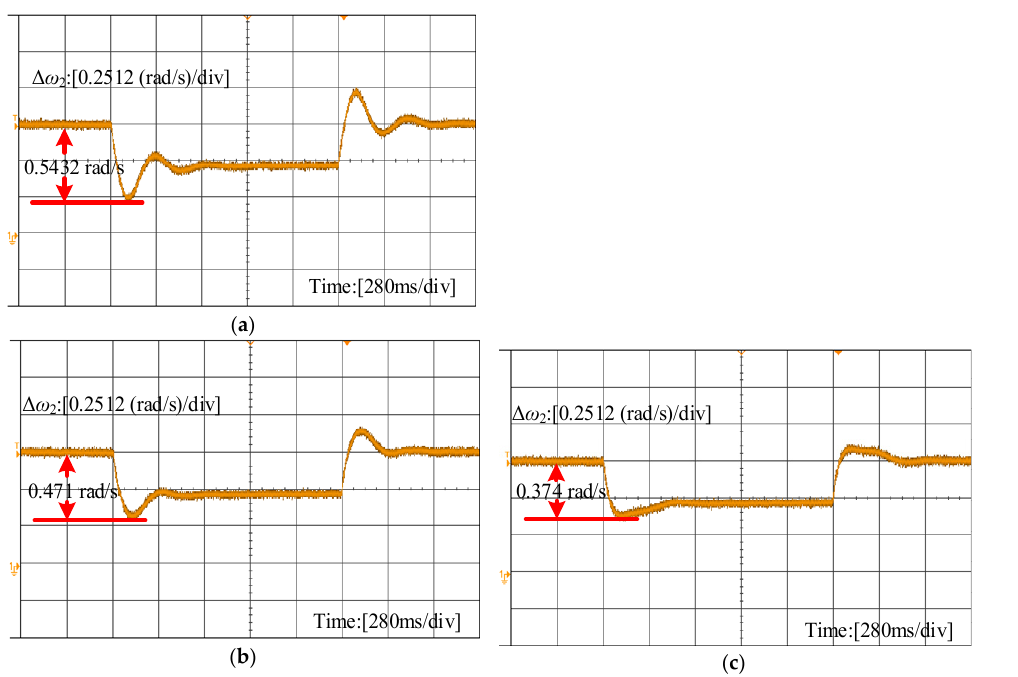
Figure 18. SG angular frequency waveform: ( a ) without the high-pass filter; ( b ) with the high-pass filter; ( c ) with the high-pass filter (parameters optimized).